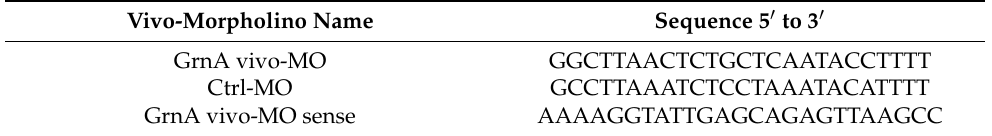
Table 1. Vivo-Morpholinos used in this